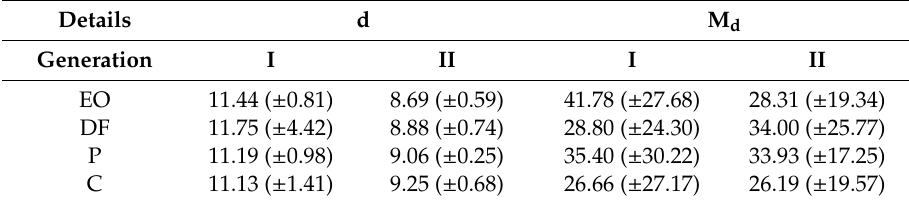
Table 3. The e ff ect of petroleum-derived substances on some biological parameters (d—duration of pre-reproductive period, M d —mean number of larvae born in time = d) of Aphis fabae Scop.